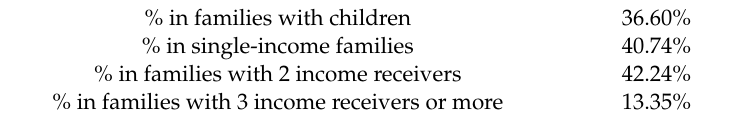
Table 1. Workers a ff ected by the Italian legislative measures issued after the lockdown (Italy).